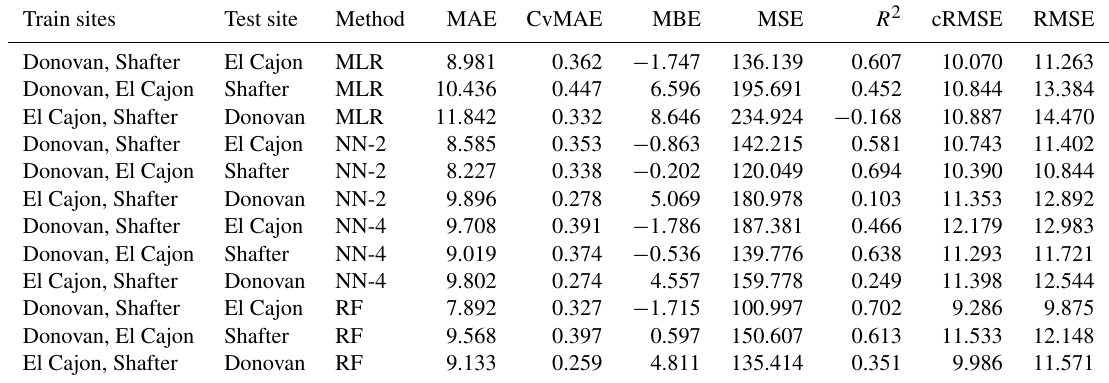
Table C12. Level 2 test results for O 3